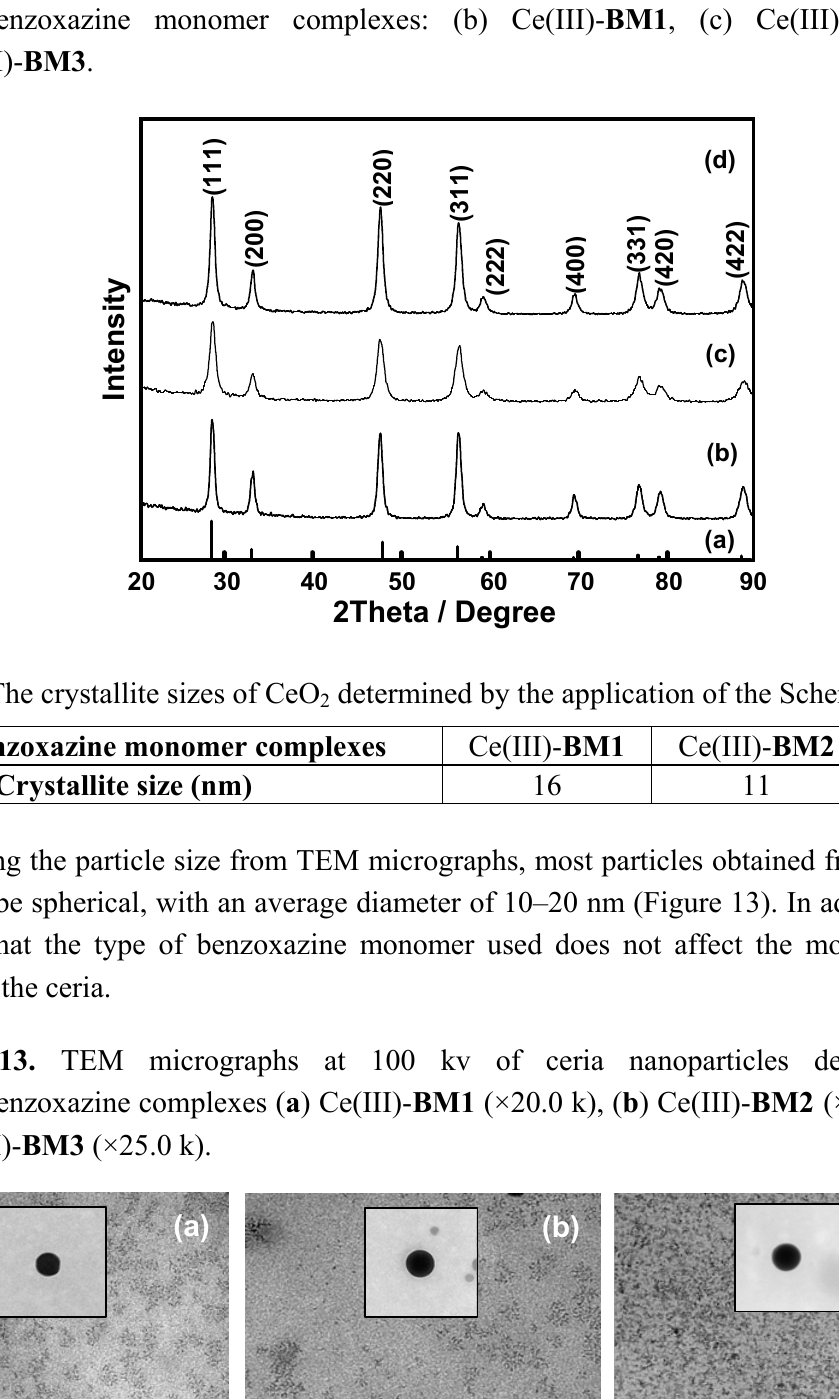
Figure 12. XRD patterns of (a) JCPDS No. 34-0394 and ceria powder derived from